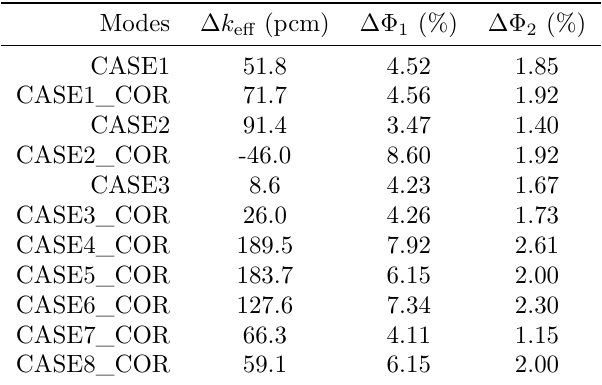
Table 2. Two group results of the the test case with